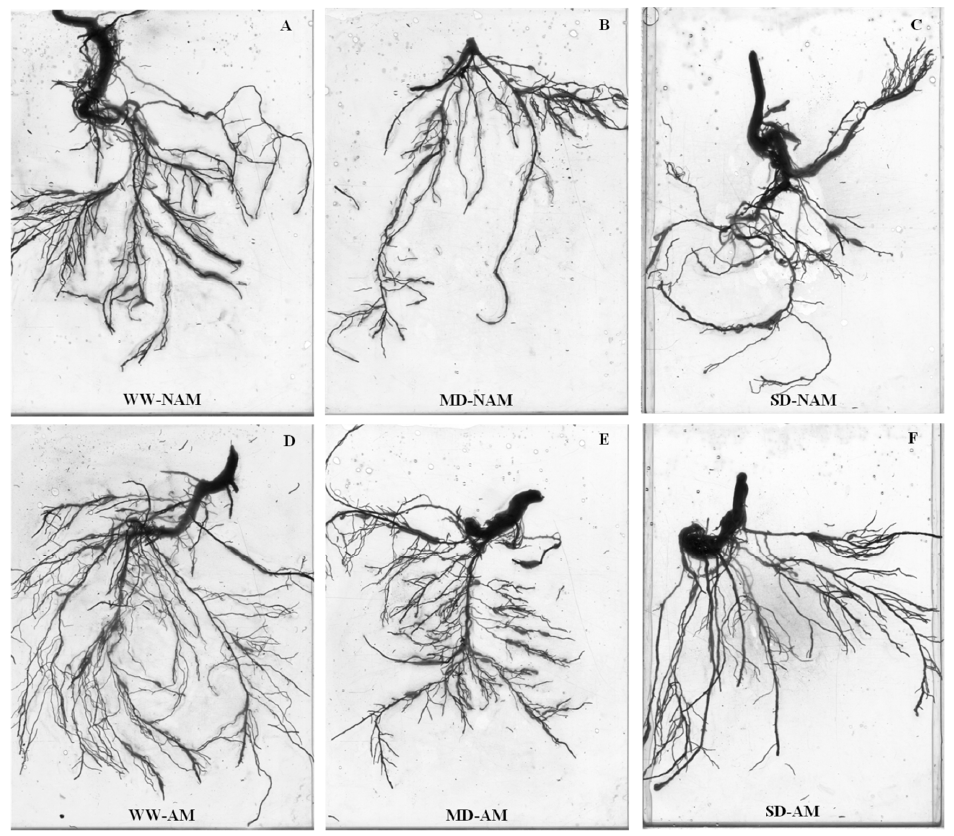
Figure 6. Effect of the arbuscular mycorrhizal fungus (AMF) Rhizophagus intraradices on the root morphology of Catalpa bungei seedlings under drought stress. ( A ), WW-NAM; ( B ) , MD-NAM; ( C ), SD-NAM; ( D ), WW-AM; ( E ), MD-AM; ( F ), SD-AM; NAM, non-AMF-inoculated; AM, AMF-inoculated; WW, well-watered; MD, moderate drought; SD, severe drought.